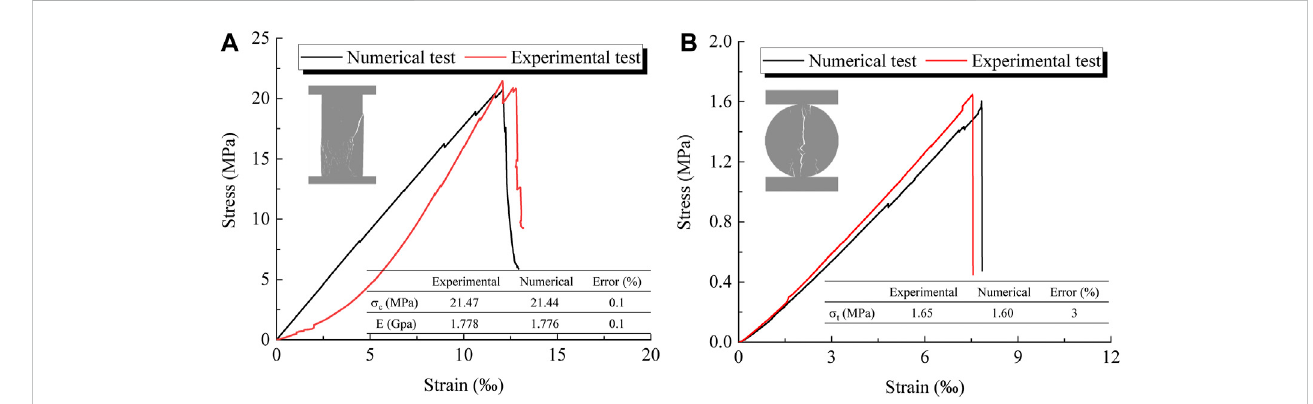
FIGURE 2 Calibration of mechanical parameters in the UDEC-Trigon model: (A) uniaxial compression tests, (B) Brazilian tension tests.